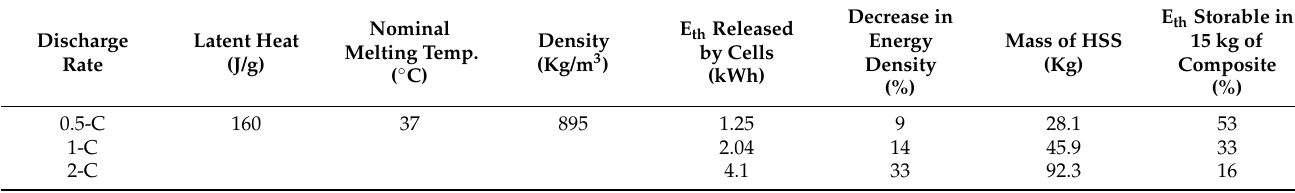
Table 3. HSS specifications for different discharge